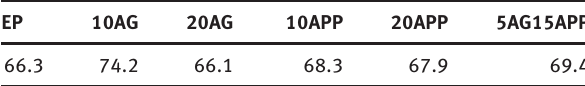
values from the DSC method. Table 3: T g